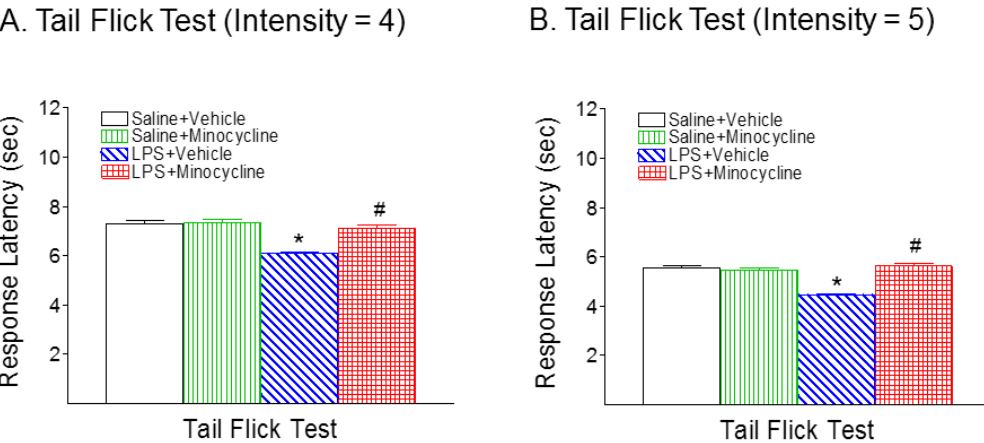
Figure 2. Minocycline attenuated systemic LPS-induced hyperalgesia in neonatal rats in the tail-flick test. Systemic LPS treatment (P5) resulted in reduction of mean latency times (second) in tail removal from a thermal stimulation (( A ), intensity = 4; ( B ), intensity = 5) in the P6 rats. Treatment with minocycline significantly reduced LPS-induced pain hypersensitivity in the neonatal rats. The results are expressed as the mean ± SEM of 16 animals in each group and were analyzed by Kruskal–Wallis one-way ANOVA on ranks, followed by the Dunn’s test. * p < 0.05 represents significant difference for the LPS + Vehicle group compared with the Saline + Vehicle group. # p < 0.05 represents significant difference for the LPS + Minocycline group compared with the LPS + Vehicle group. ( n = 16).